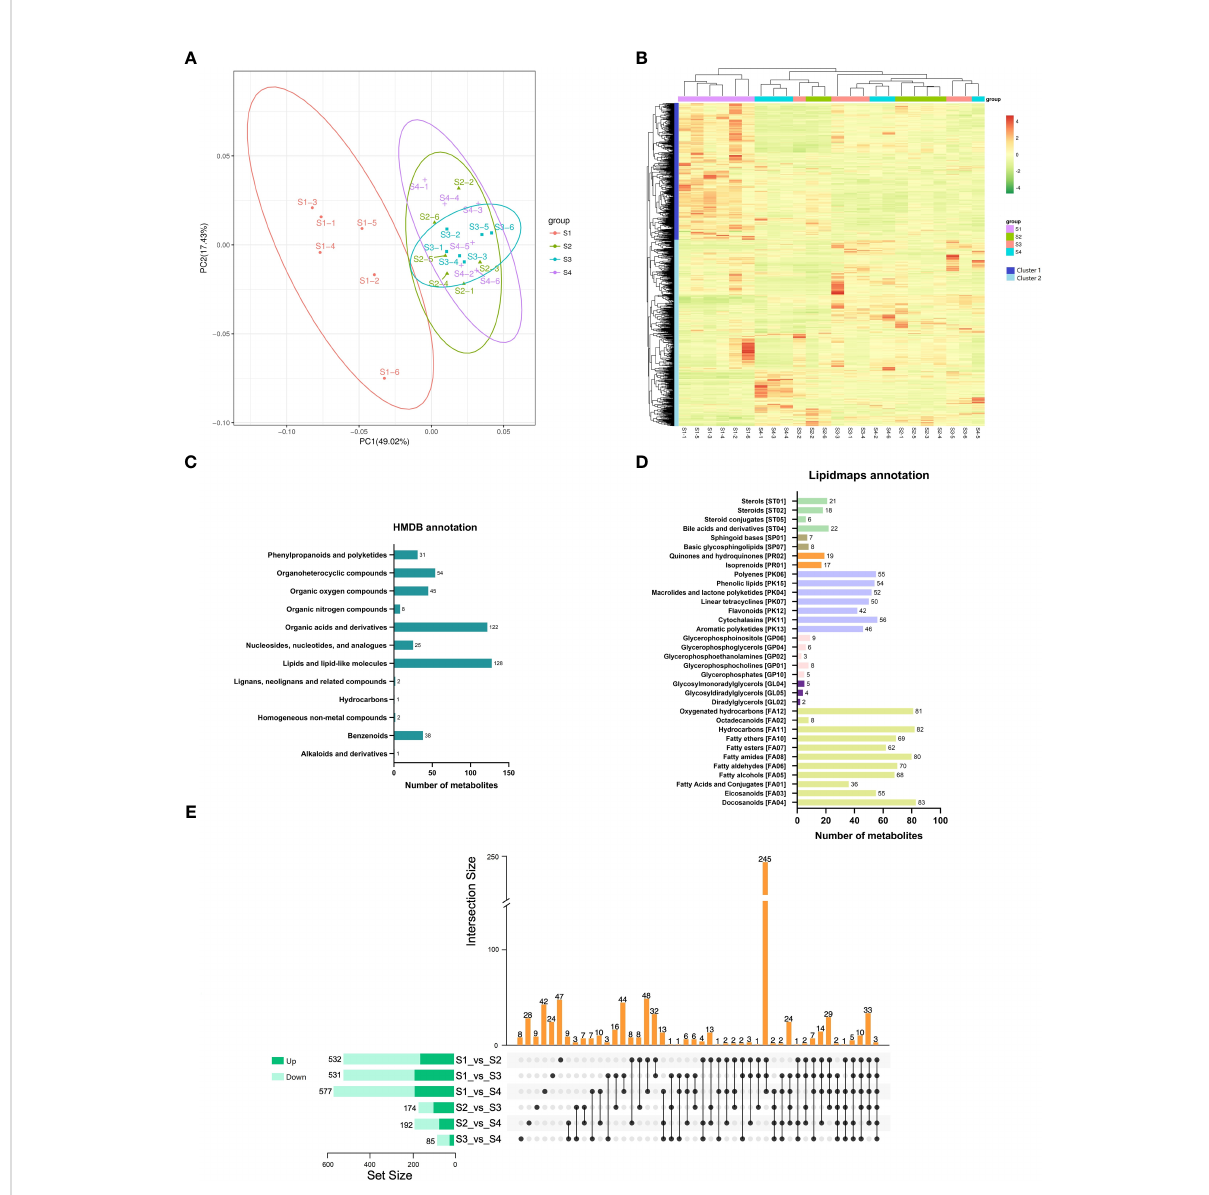
FIGURE 2 Metabolic analysis of lettuce fl eshy stem during four expansion stages (S1, S2, S3, and S4). (A) Principal component analysis (PCA) of the identi fi ed metabolites in four expansion stages (S1, S2, S3, and S4). (B) Heatmaps of all metabolites during the four expansion stages (S1, S2, S3, and S4). (C) Taxonomic annotations of metabolites by HMDB database. (D) Taxonomic annotations of metabolites by LIPIDMAPS database. (E) Comparisons of up-regulated metabolites (dark green) and down-regulated metabolites (light green) in the paired comparison of each expansion